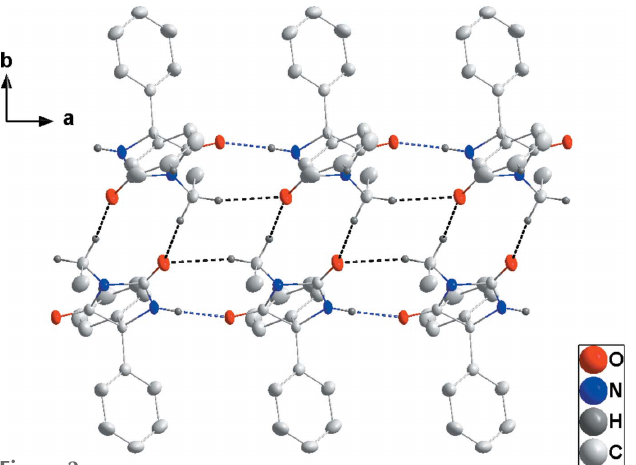
Figure 2 Detail of the chains formed along a by N—H (cid:3)(cid:3)(cid:3) O and C—H (cid:3)(cid:3)(cid:3) O hydrogen bonds (blue and black dashed lines, respectively) and linked into ribbons parallel to (011).